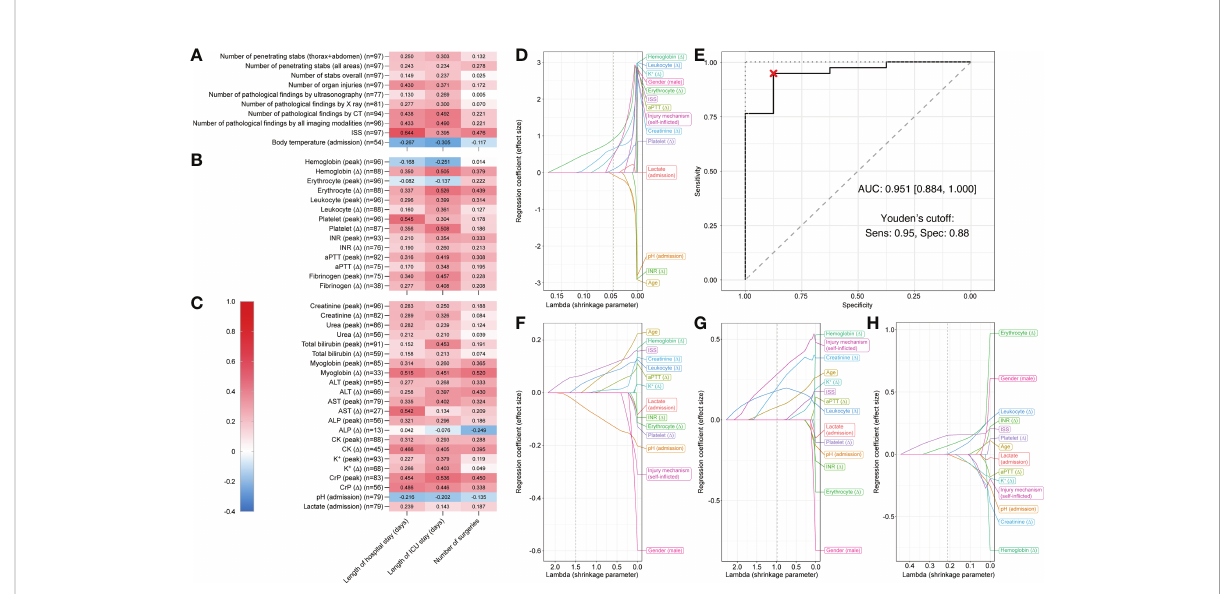
FIGURE 4 Correlation matrix showing Spearman ’ s rank correlation coef fi cients and Least Absolute Shrinkage and Selection Operator (LASSO) plots showing regression coef fi cients for patients who suffered organ injuries. Correlations between three different outcome parameters (length of hospital stay, length of ICU stay, and number of surgeries) and (A) injury speci fi cs, (B) routine hematology and coagulation, and (C) serum biochemistry and venous blood gas laboratory parameters for penetrating injuries (n = 97). Multivariable LASSO trace plots indicate potentially predictive sets of variables for (D) ICU admission (yes/no). (E) Receiver operating characteristic (ROC) curve for the LASSO model of ICU admission (yes/no). Youden ’ s cutoff indicates the optimal cutoff based on sensitivity (Sens.) and speci fi city (Spec). (F) Further LASSO trace plots for length of hospital stay, (G) length of ICU stay, and (H) number surgeries. Gray dotted line displays optimal lambda value calculated via cross- validation. AUC, area under the